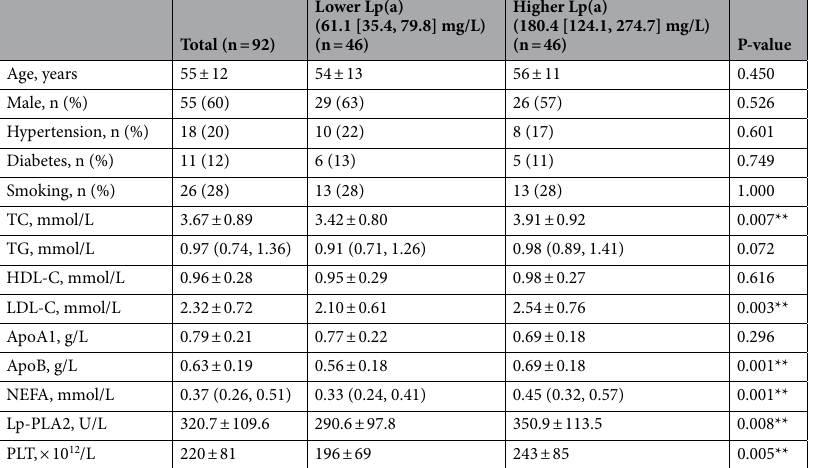
Table 1. Characteristics of population. Lp ( a ) lipoprotein a, TC total cholesterol, TG triglyceride, HDL-C high density lipoprotein-cholesterol, LDL-C low density lipoprotein-cholesterol, ApoA1 apolipoprotein A1, ApoB apolipoprotein B, NEFA nonesterified fatty acid, Lp-PLA2 lipoprotein-associated phospholipase A2, PLT platelet